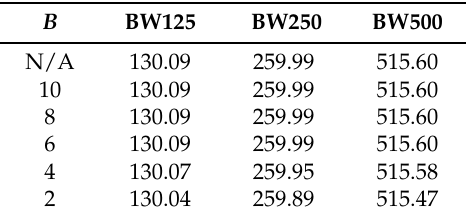
Table 8. Measured occupied bandwidth (OBW) (kHz) for filtered and quantized LoRa signals with SF = 10, varying BW , and varying B